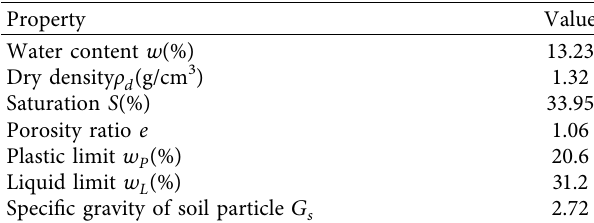
Table 1: Physical properties of